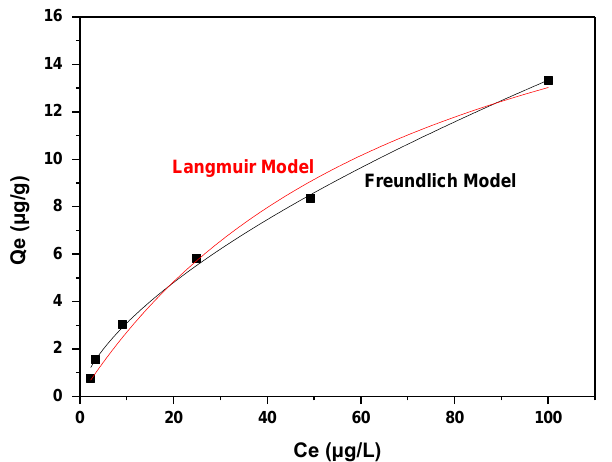
Figure 5. Langmuir and Freundlich isotherm models for the adsorption of As(III) (25 – 500 μg/L) onto the combination of GO (0.2 g/L) and GFH (0.1 g/L), pH 7.0 ± 0.1, T = 298 K, contact time 24 h, in deionized water. Table 1. Constants of Langmuir and Freundlich isotherm model for the adsorption of As(III) onto the combination of GO (0.2 g/L) and GFH (0.1 g/L), pH 7.0 ± 0.1, T = 298 K, contact time 24 h, in deionized water.